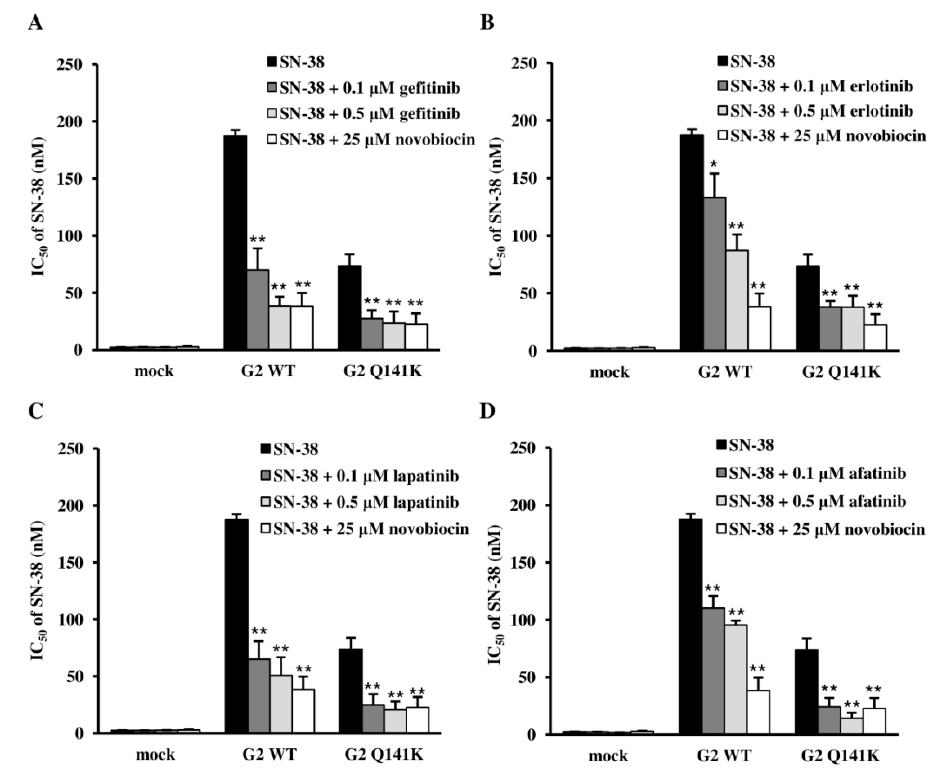
Figure 6. Effects of EGFR TKIs on ABCG2 transport activity. SN-38 alone or SN-38 combined with gefitinib ( A ), erlotinib ( B ), lapatinib ( C ), or afatinib ( D ) was added to Flp-In-293/mock cells, Flp-In-293/ABCG2 WT cells, and Flp-In-293/ABCG2 Q141K cells. Each EGFR TKI was added at two concentrations (0.1 µ M and 0.5 µ M). After incubation for 72 h, the cell viability was evaluated by the MTT assay. P -values were determined by ANOVA and Tukey’s test (* P < 0.05 and ** P < 0.01. versus SN-38 alone). Data are expressed as the mean ± SD. Each experiment was repeated three times.